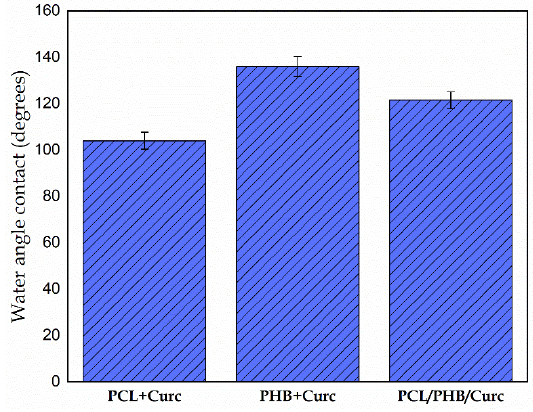
Figure 10. Water contact angle of electrospun membranes.